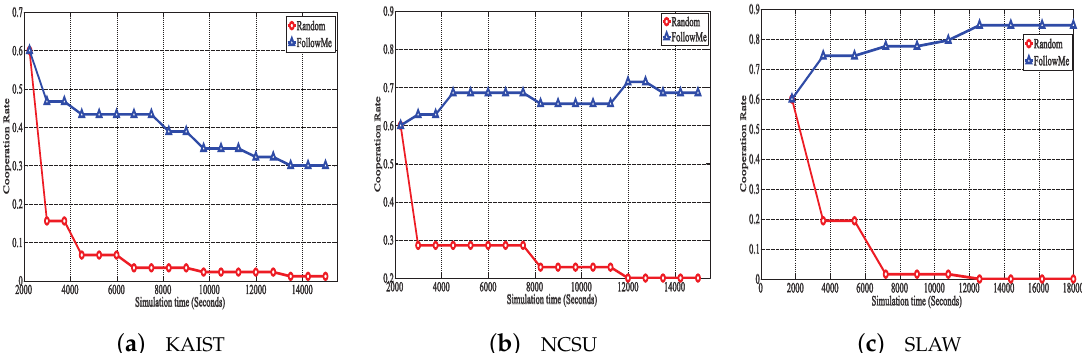
Figure 2. Cooperation rate of FollowME and Random with different routing protocols under three scenarios.